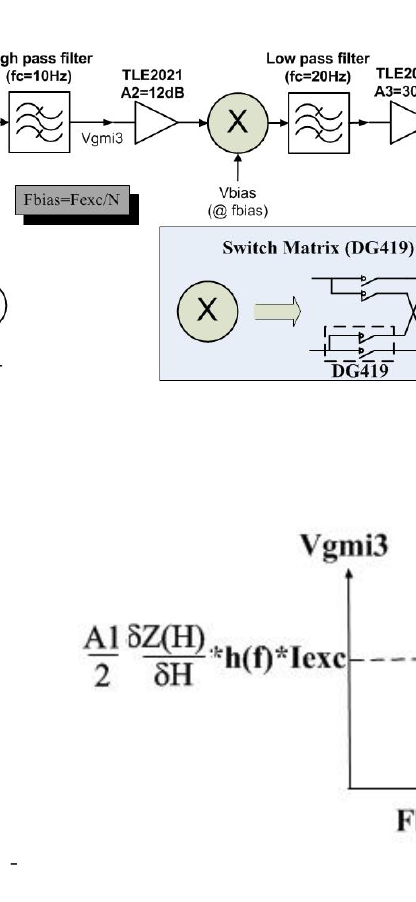
Figure 4. Racetrack (a) and cylindrical (b) wire-wound ferromagnetic core. (c) Hybrid sensor: induction sensor and wire-wound GMI inside an aluminium tube.